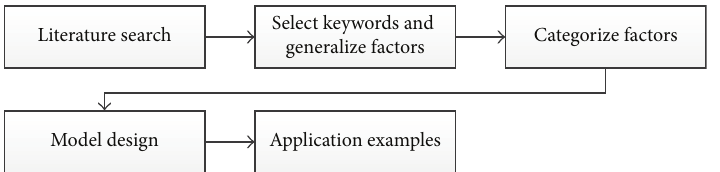
Figure 1: GBL model development.